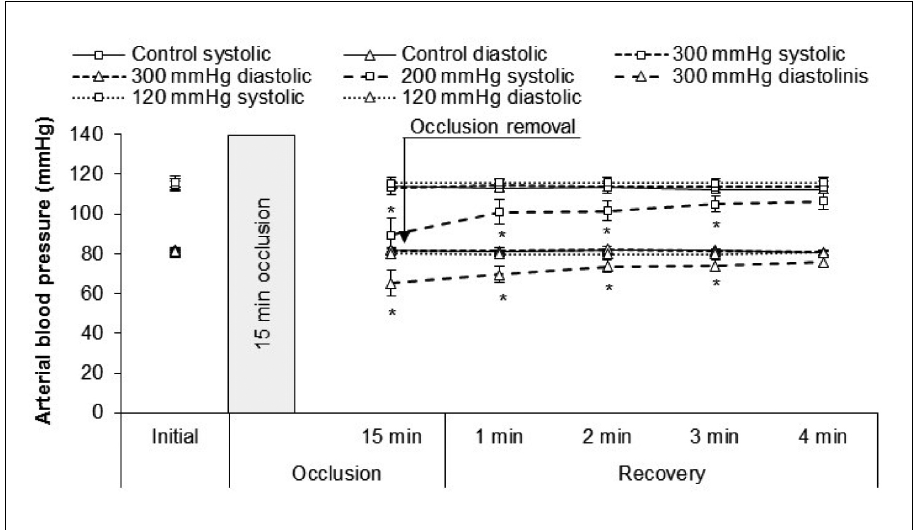
Figure 4. Changes of arterial blood pressure in experimental groups after removal of 120; 200 or 300 mmHg